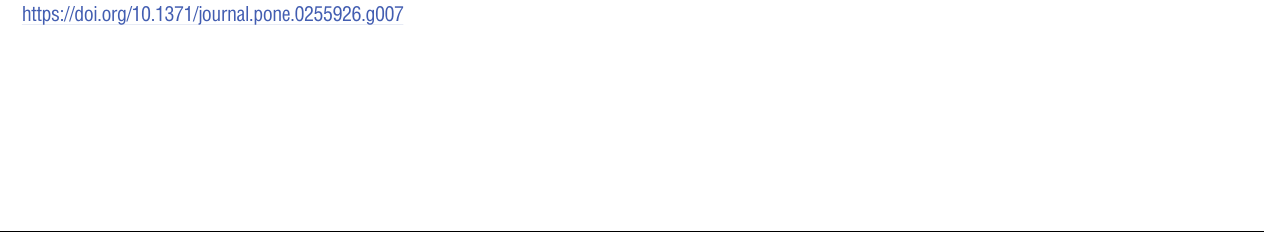
PLOS ONE | https://doi.org/10.1371/journal.pone.0255926 August 16, 2021 12 /